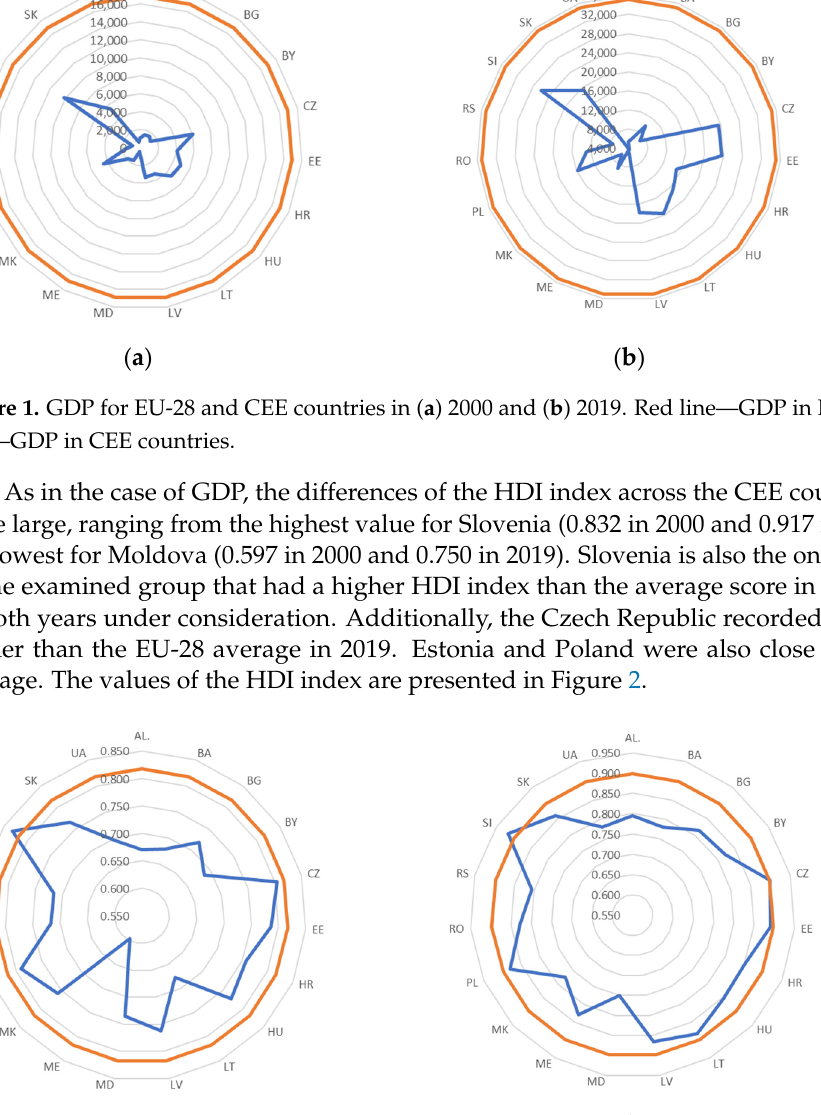
Table 3. Pearson correlation coefficient for the CEE countries.